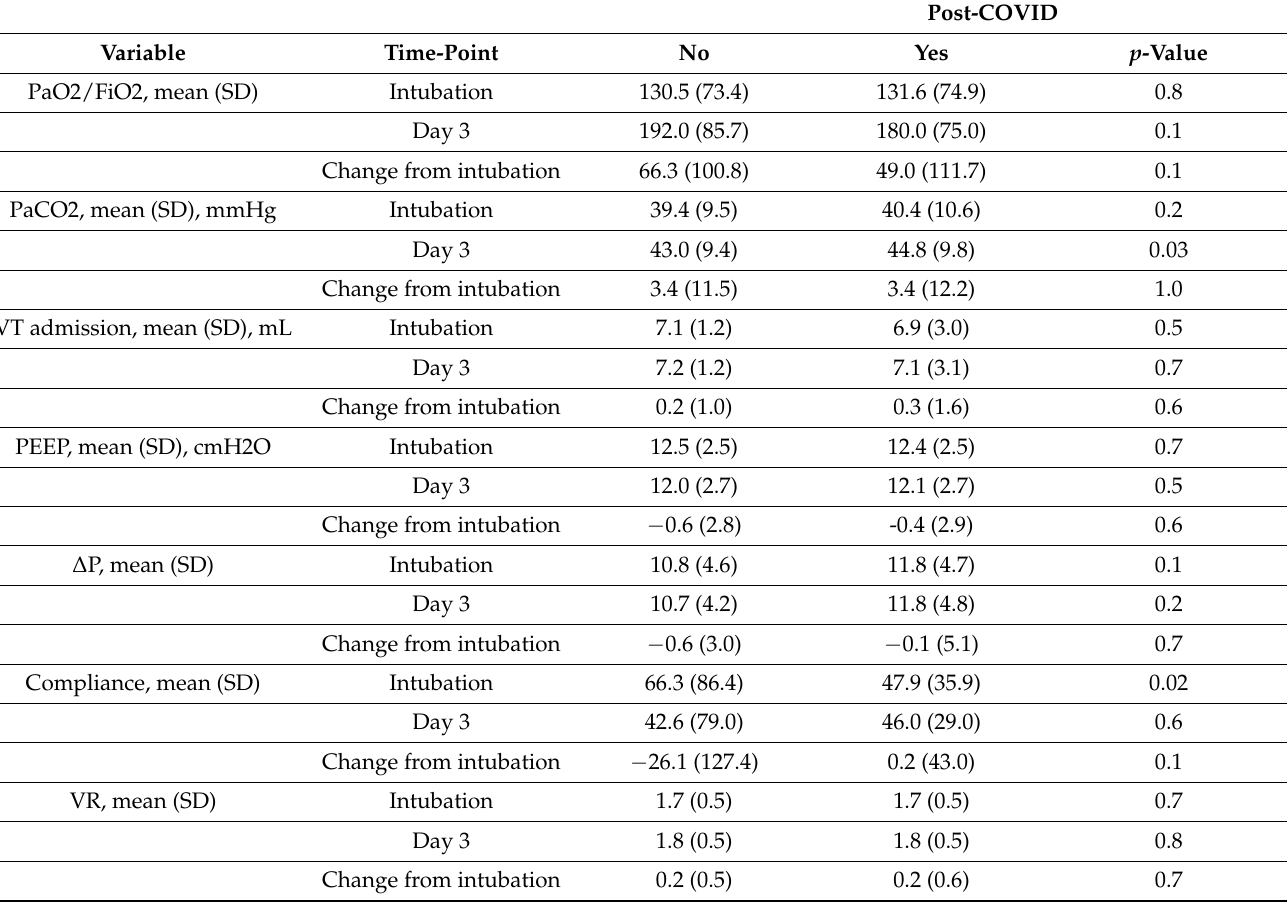
Table 3. Respiratory parameters in patients with invasive mechanical ventilation based on persistent post-COVID-19 symptoms at 3-month follow-up.